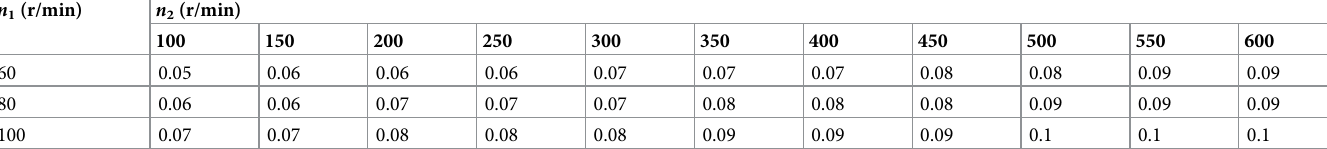
As shown in Fig 4, by comparing the productivity and power consumption of sand and soy- beans under the same experiment parameter, it can be found that the productivity and power consumption of conveying fine sand are about twice that of conveying soybeans, for the reason that the bulk density of sand is twice that of soybeans.